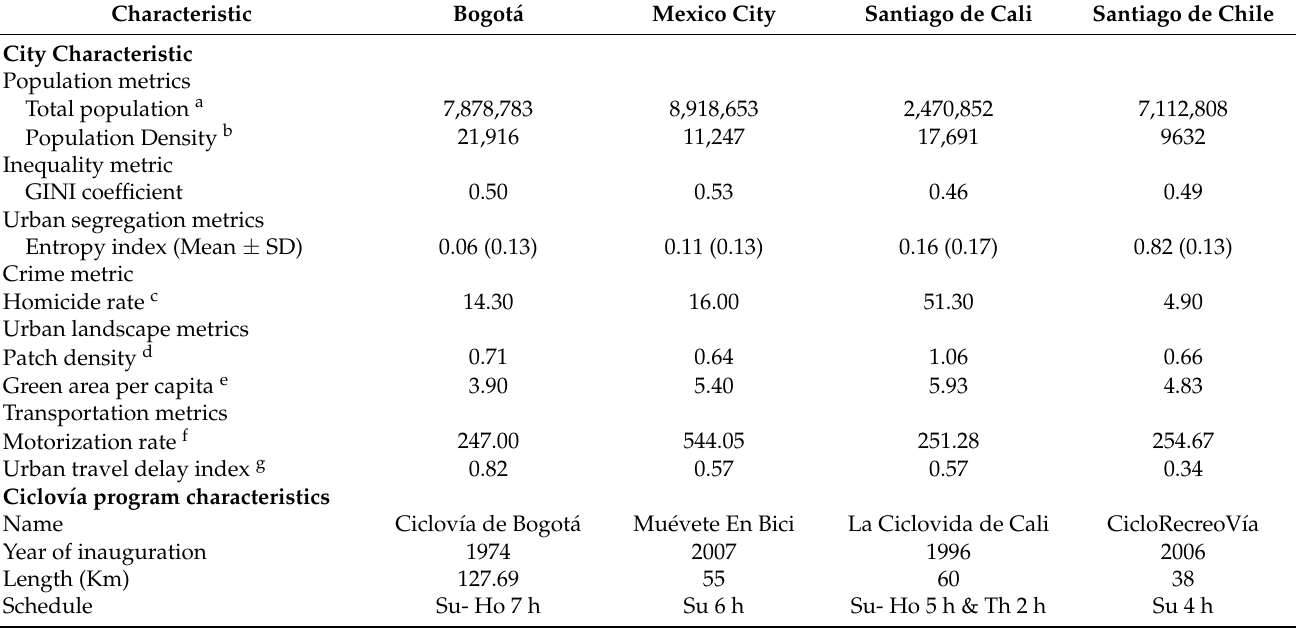
Table 1. City and Ciclov í a Recreativa program characteristics by study